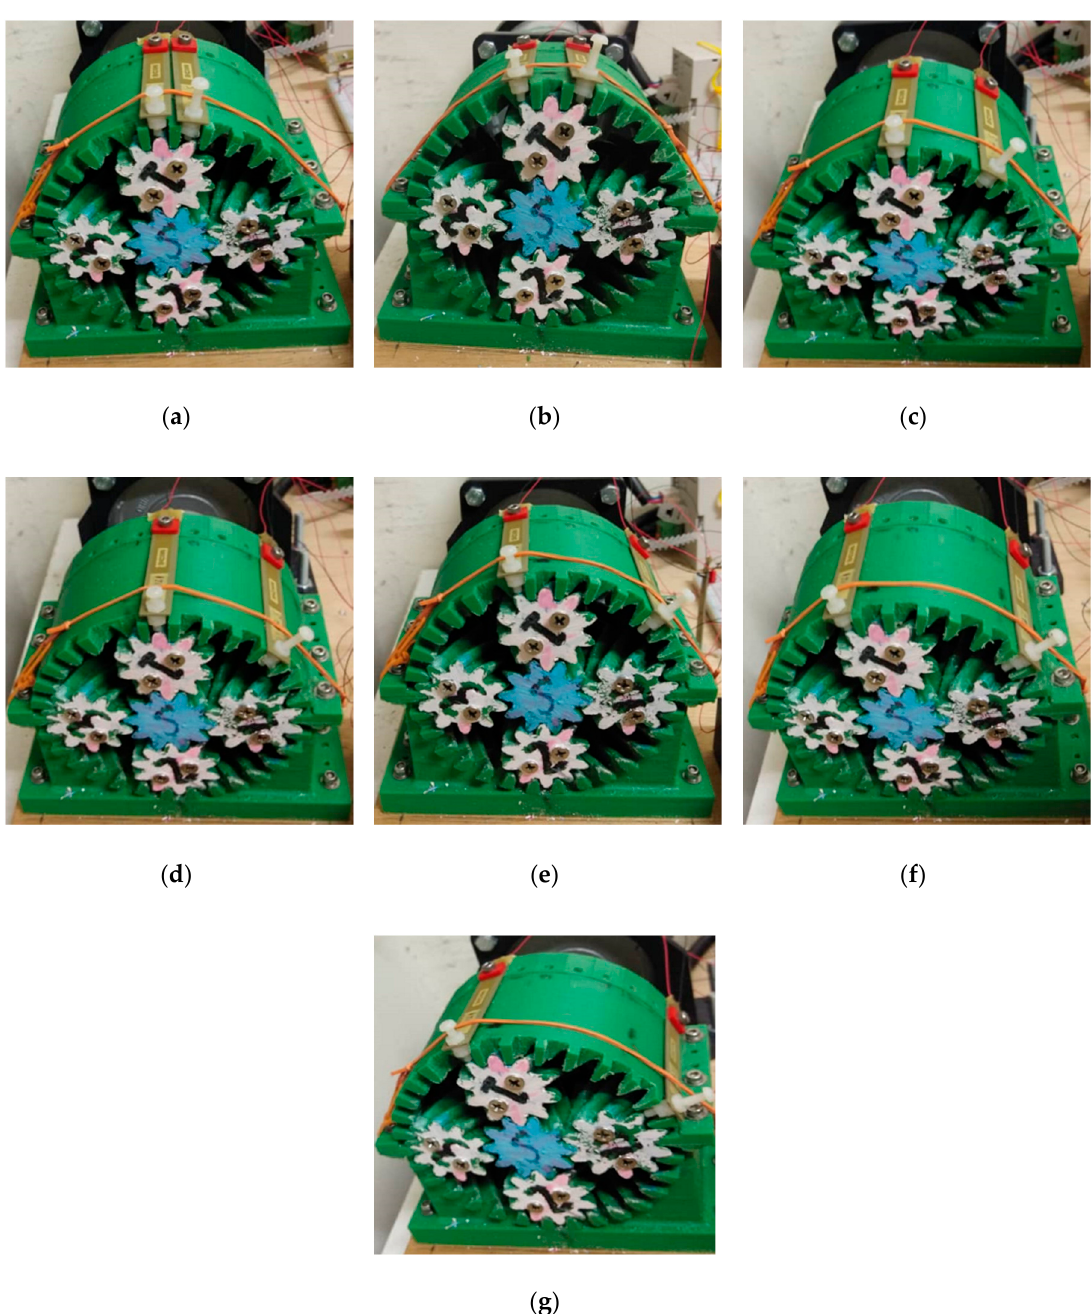
Figure 8. Two PZTs with an angular distance of ( a ) 12 degrees, ( b ) 24 degrees, ( c ) 36 degrees, ( d ) 48 degrees, ( e ) 60 degrees, ( f ) 72 degrees and ( g ) 84 degrees.